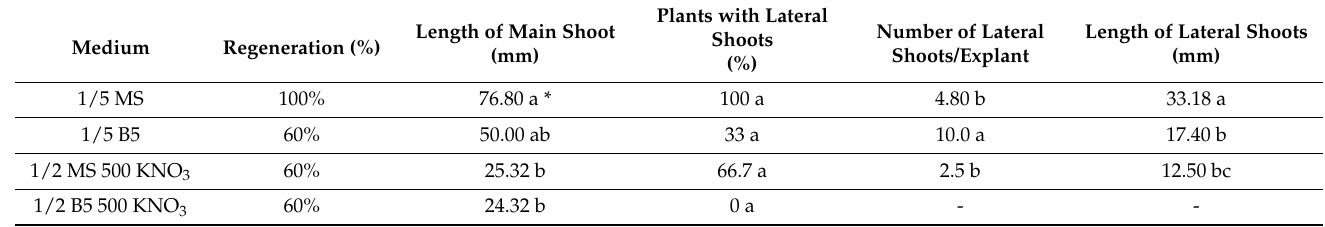
Table 2. Influence of medium type on the growth and development of Aldrovanda vesiculosa shoots in vitro in the first passage.